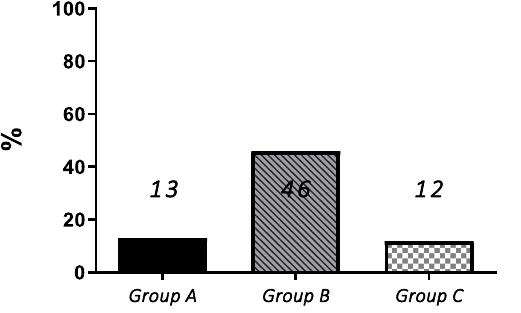
Figure 2. Percentage of “poor responders” according to ∆HT < 1 SDS in the three groups.